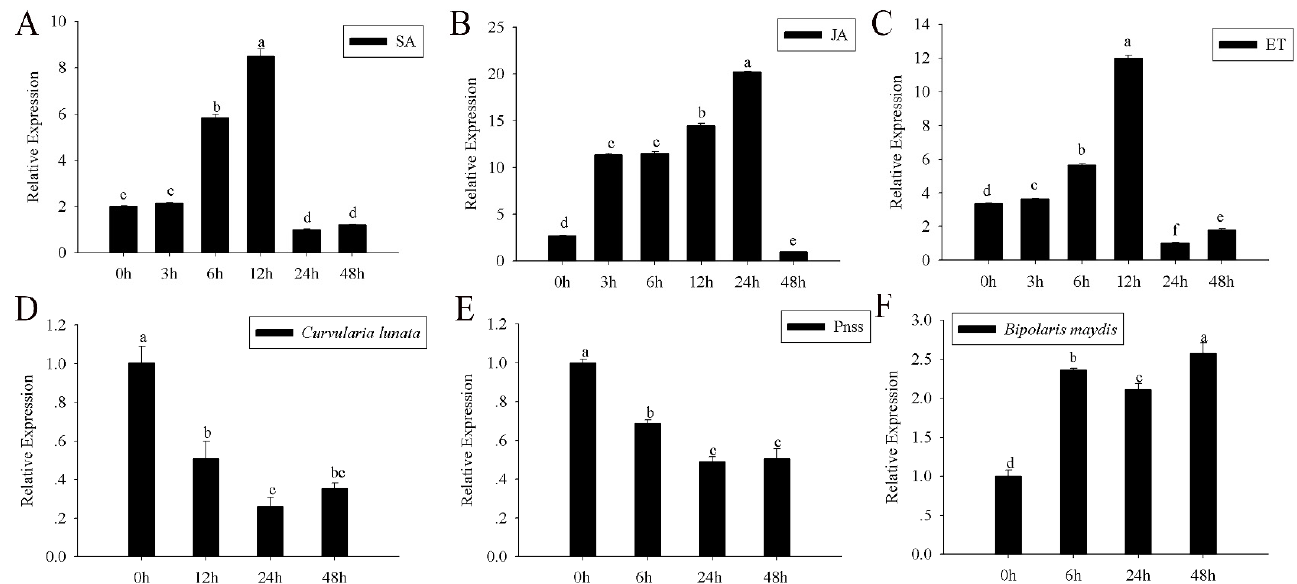
Figure 3. Relative expression levels of ZmGLP1 under six different treatments over time. ( A ) Salicylic acid application, ( B ) jasmonic acid application, ( C ) ethephon application, ( D ) the conidial suspension of Curvularia lunata , ( E ) Pantoea stewartii suspensions, ( F ) the conidial suspension of Bipolaris maydis . ZmActin1 and GADPH were used as reference genes for normalization. Different letters in subfigures ( A – F ) indicated significant difference between different samples by Duncan’s post-hoc test. Data are presented as the mean ± SD based on three biological replicates.